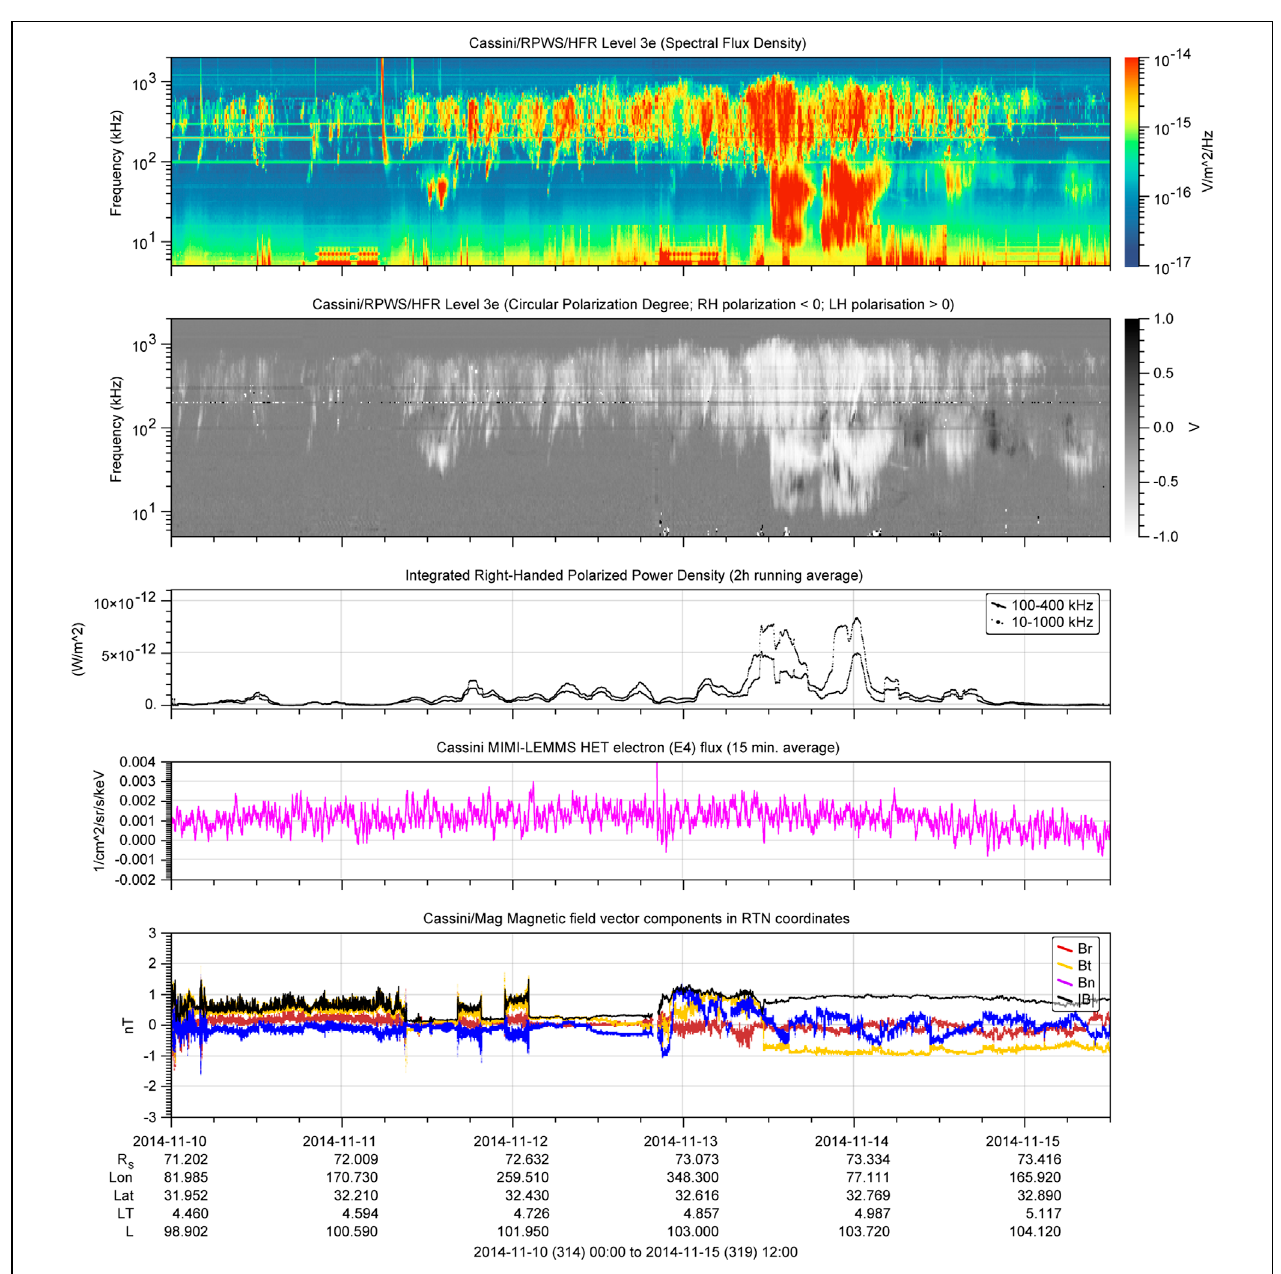
FIGURE 7 | Zoomed-in version of Figure 4 , from Nov. 10th 00:00 SCET to Nov. 15th, 12:00 SCET. The panel description is the same as for Figure 4 . Times are given in the format YYYY-MM-DD, and